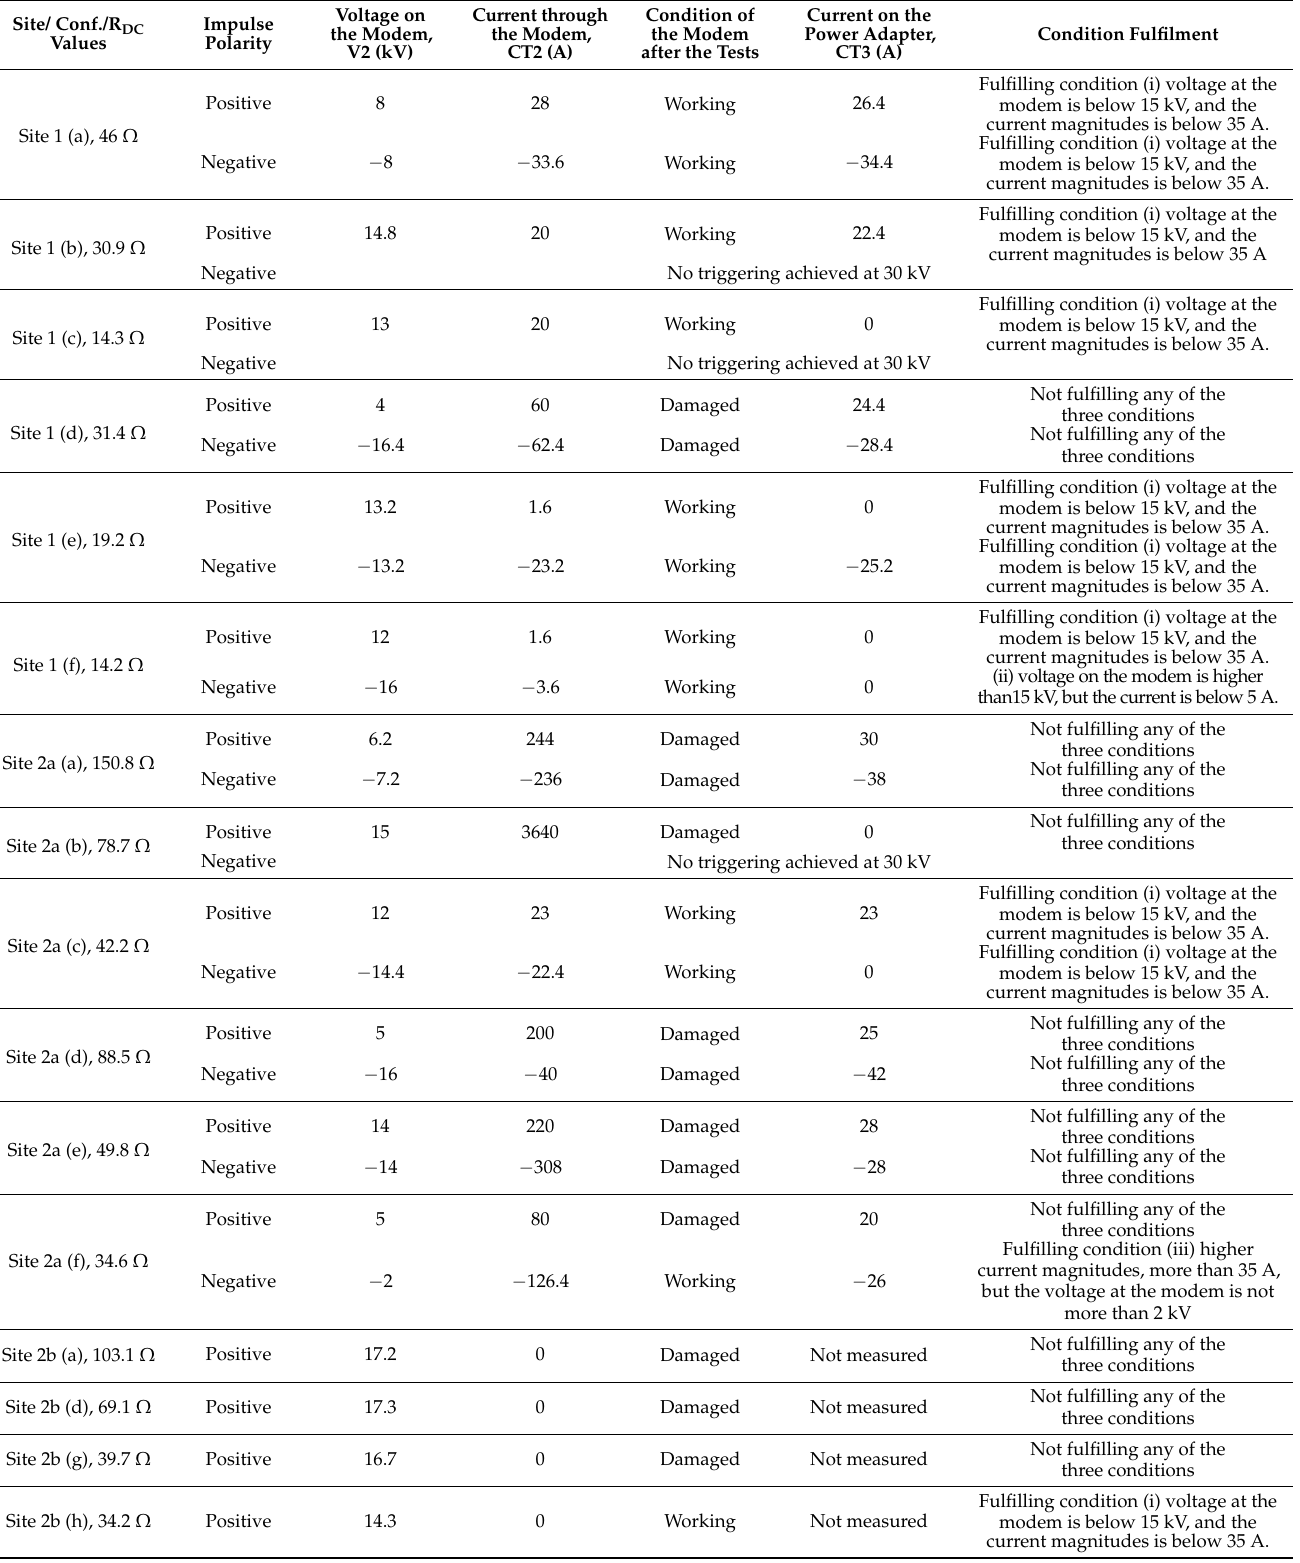
Table 4. Voltage and current magnitudes and the condition of the modem for various ground